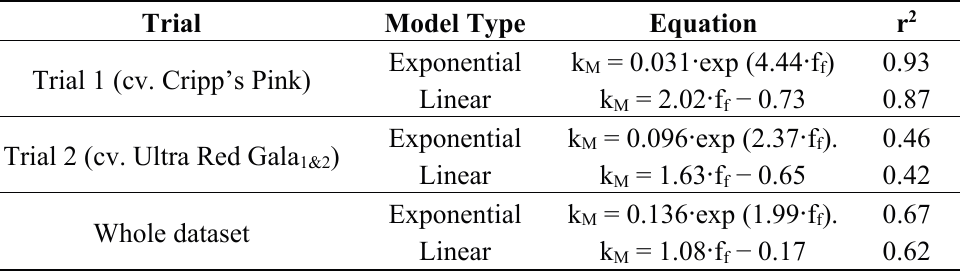
Table 2. Models for light extinction coefficient as a function of the fractions of foliage cover (f f ) for the both trial sites.